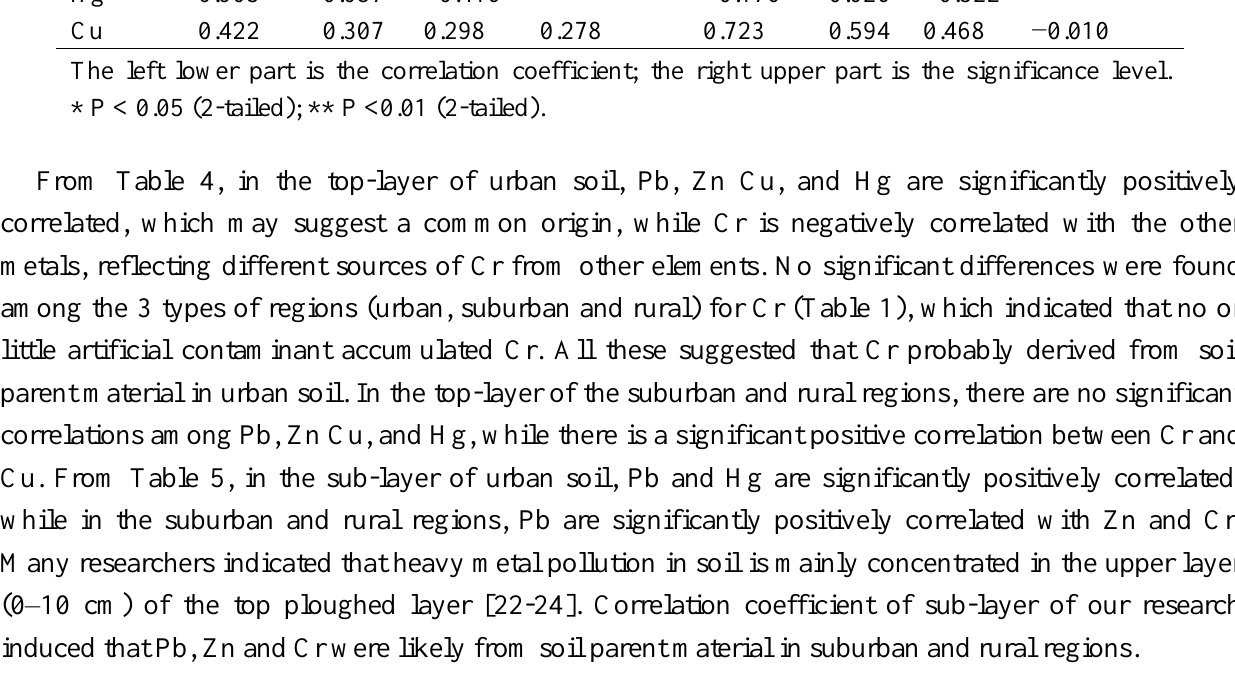
Table 5. Pearson’s correlation matrix for the metal concentrations of sub-layer of soil. Urban Suburban and rural area Element Pb Zn Cr Hg Pb Zn Cr Hg Pb Zn 0.202 0.772 * Cr −0.590 0.011 0.885 ** 0.553 Hg 0.903 ** 0.057 −0.416 −0.176 0.026 −0.322 Cu 0.422 0.307 0.298 0.278 0.723 0.594 0.468 −0.010 The left lower part is the correlation coefficient; the right upper part is the significance